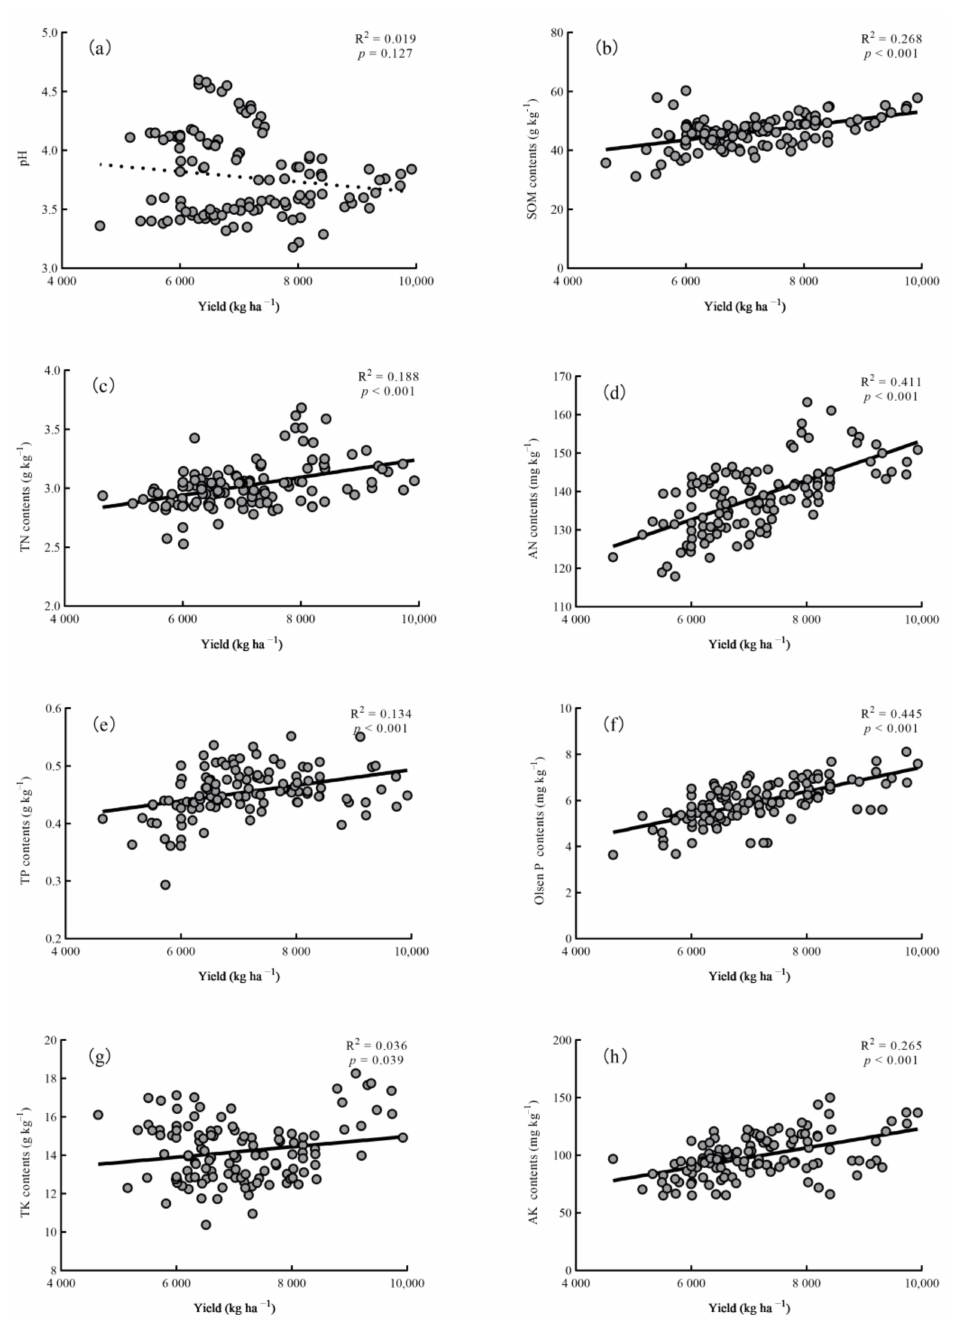
Figure 4. Relationships of bamboo-shoot yield to the soil pH ( a ), SOM ( b ), TN ( c ), AN ( d ), TP ( e ), Olsen P ( f ), TK ( g ), and AK ( h ) in C. pachystachys shoot forest. SOM: soil organic matter; TN: total nitrogen; AN: available nitrogen; TP: total phosphorus; Olsen P: Olsen phosphorus; TK: total potassium; AK: available